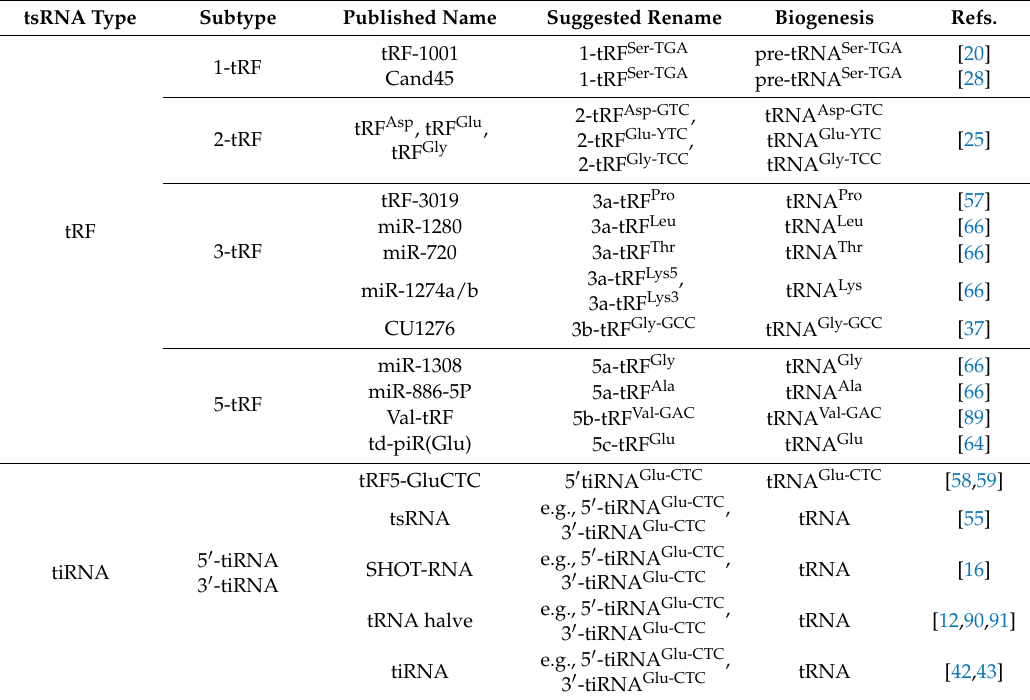
Table 1. The published names and suggested renaming of